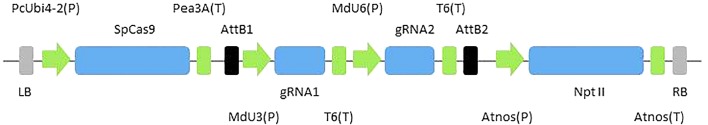
CRISPR-Cas expression construct. The Cas9 gene from Streptococcus pyogenes is driven by PcUbi4-2 promoter (P) from parsley (Petroselinum crispum) and transcription is terminated by the Pea3a terminator (T) from pea (Pisum sativum). gRNA1 and 2 are, respectively, driven by MdU3 and MdU6 promoters from Malus domestica and transcription is terminated by a polyT terminator. Transformants are selected with a nptII gene controlled by nos promoter and terminator from Agrobacterium tumefaciens. AttB1 and 2: sites resulting from the Gateway® LR recombination. LB and RB: T-DNA borders.